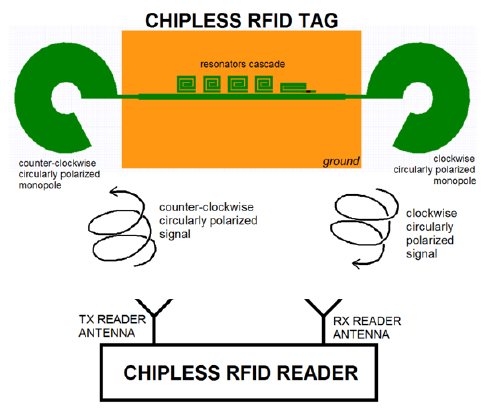
Figure 8. Schema of a chipless tag system operating in circular polarization.